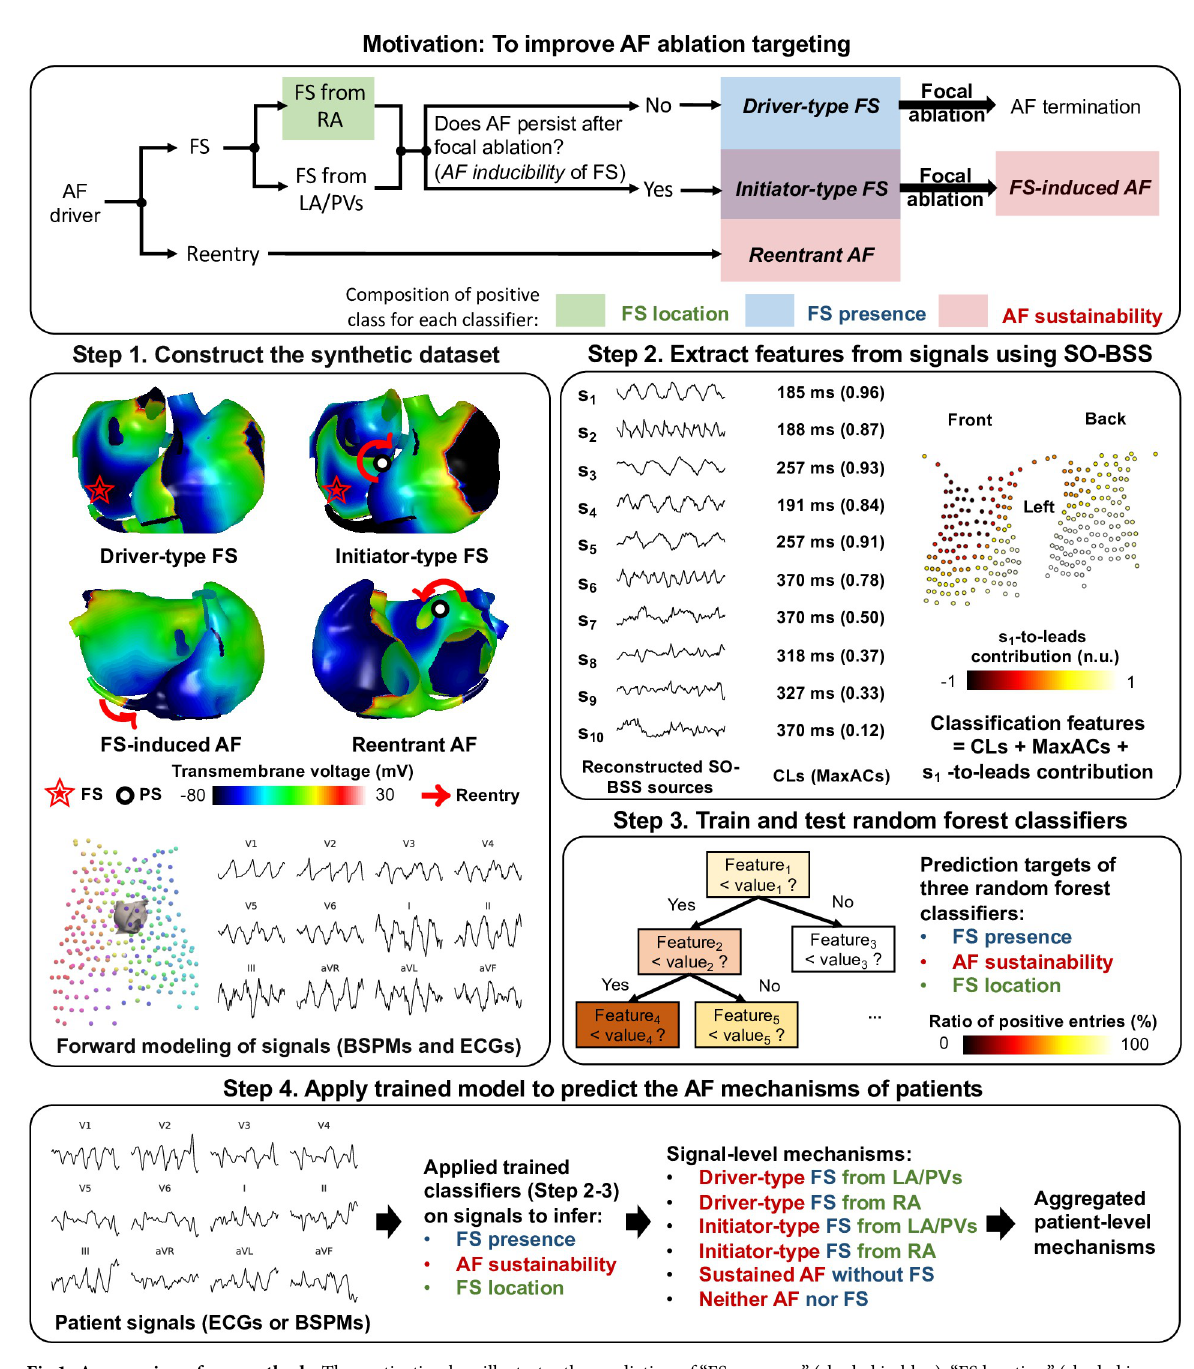
Fig 1. An overview of our methods. The motivation box illustrates the prediction of “FS presence” (shaded in blue), “FS location” (shaded in green), and “AF sustainability” (shaded in red) in selecting the ablation targets for AF, where shaded rectangles indicate the composition of the positive class for each classifier. Note that the initiator-type FS is in both classes of “FS presence” and “AF sustainability”. The bold italic fonts mark the four simulation categories in our synthetic dataset. Steps 1 to 3 describe the training process of our classifiers on synthetic data, and Step 4 illustrates the application of the trained classifiers on patient signals to non-invasively detect their AF mechanisms. In Step 1, white spheres show phase singularity (PS) points, the red arrows show the wavefront movement of rotors, and the red stars mark the focal sites.